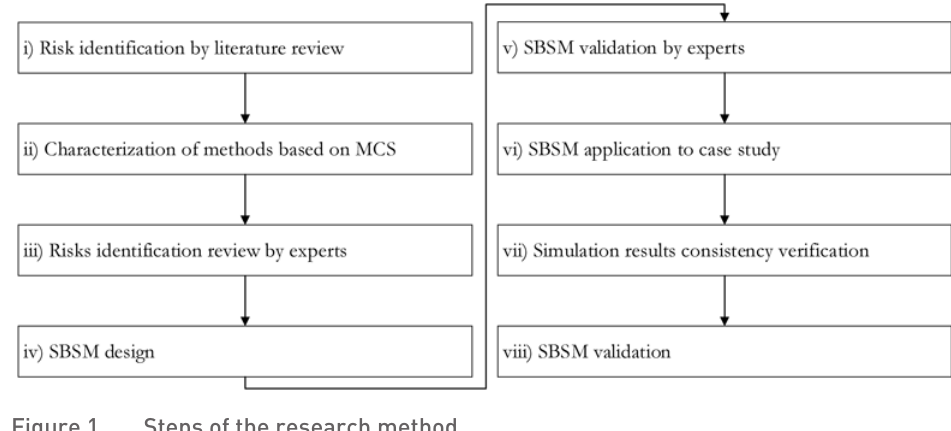
Steps of the research